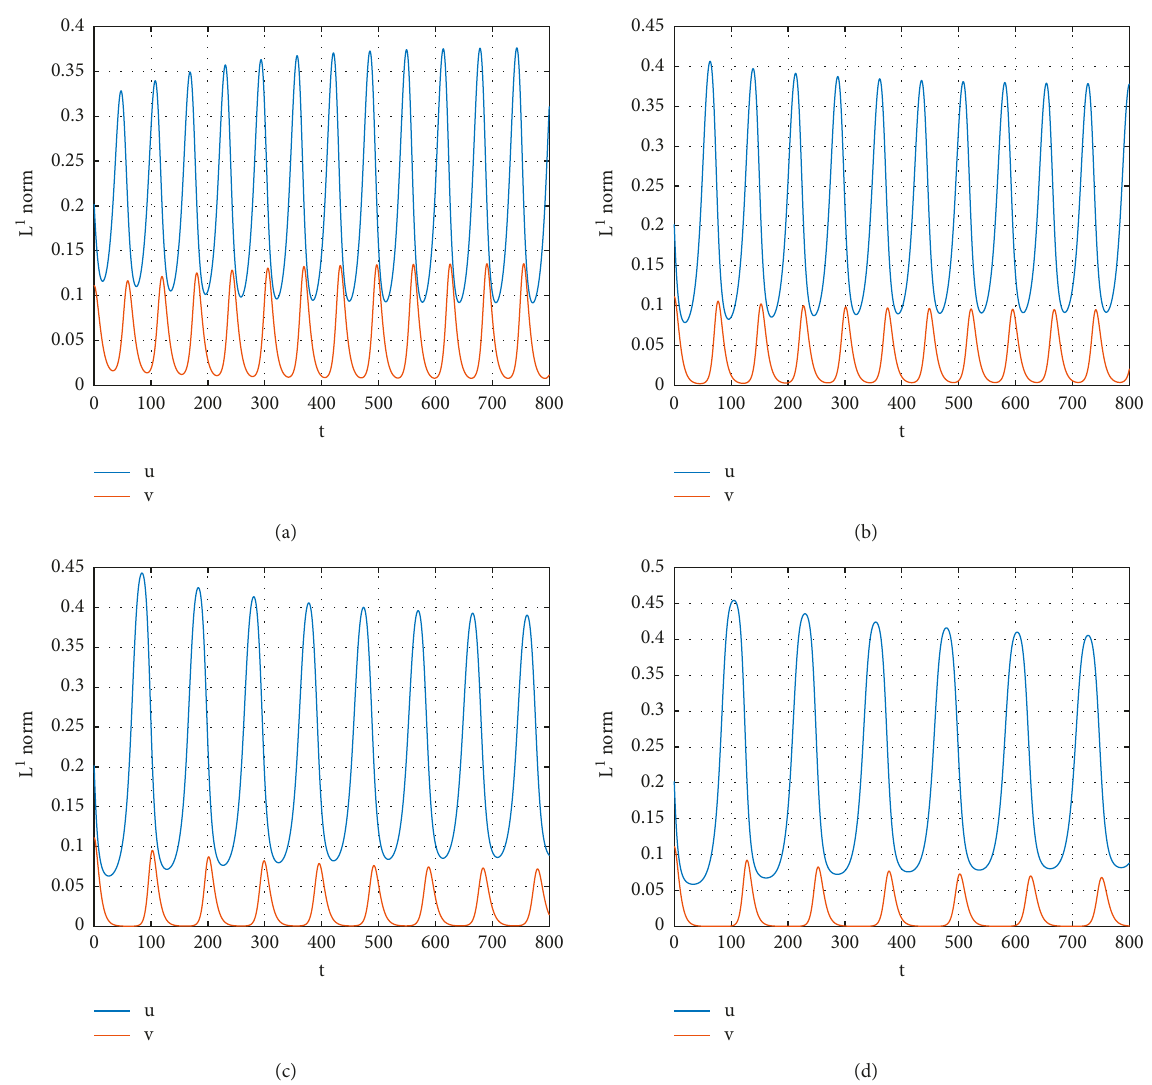
Figure 2: The effects of parameter f for T � 800 , l � 2. The values of parameter f are as follows: (a) f � 5; (b) f � 50; (c) f � 500; (d) f �